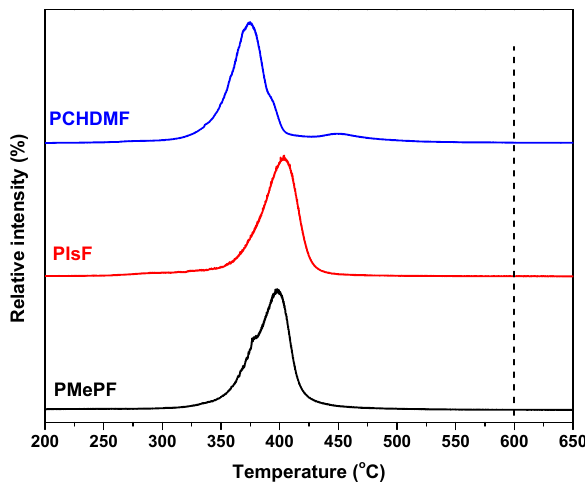
Figure 12. EGA analysis of the polyesters.